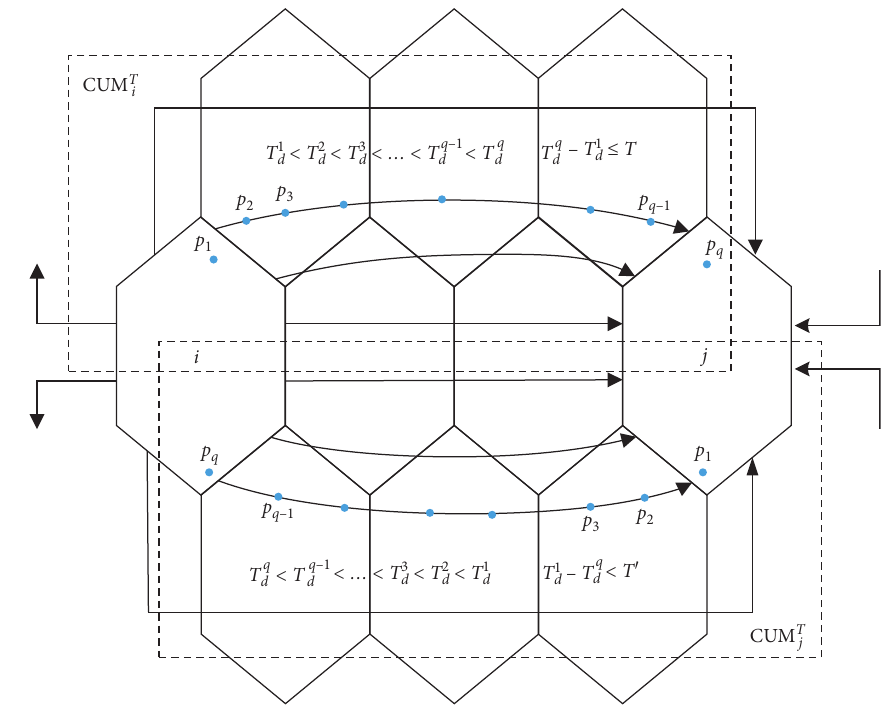
Figure 4: Data processing about CUM T